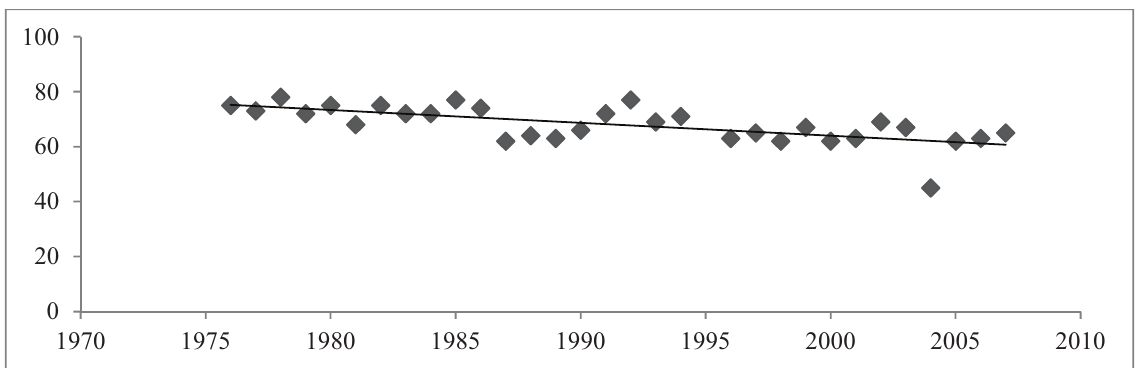
Figure 2. Total Species Richness in March and September months